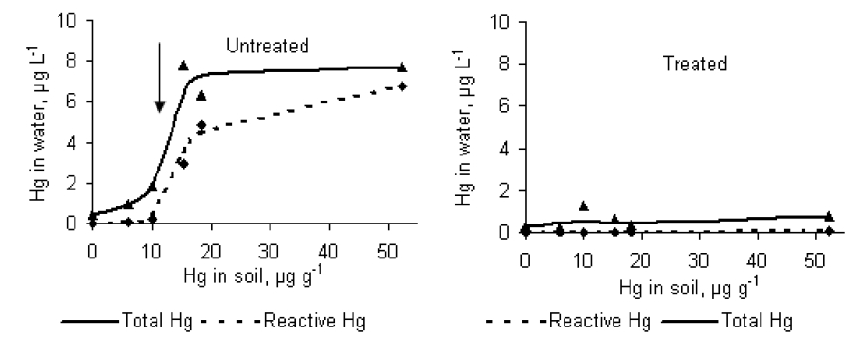
Fig. 1 Hg content - total and reactive, in percolating waters: (1) three hours after the sawing, (2) on the 5 th day, and (3) on the 9 th day of the experiment, untreated (left) and treated (right) variants.